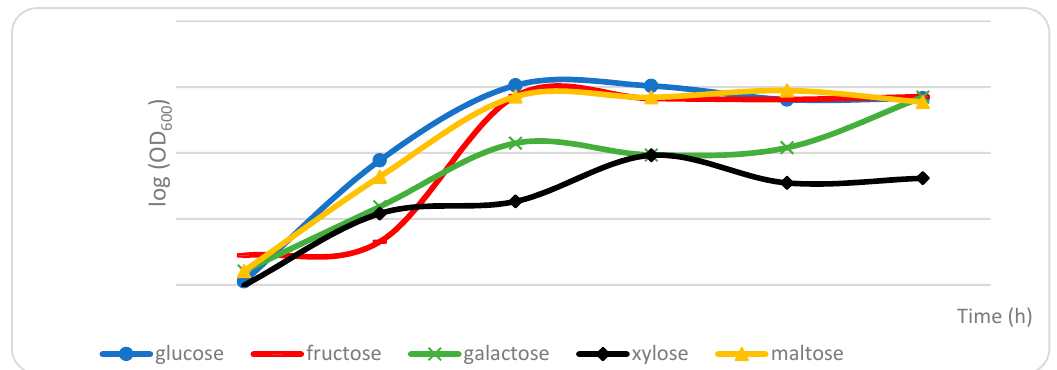
Figure 1. Growth curves of S. fibuligera KJJ81 cultivated in different types of media containing different carbon sources such as glucose, fructose, galactose, xylose, and maltose.